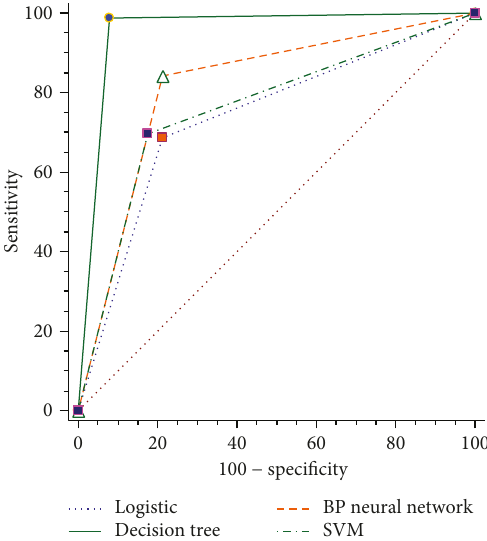
Figure 6: The ROC curve of four prediction models.